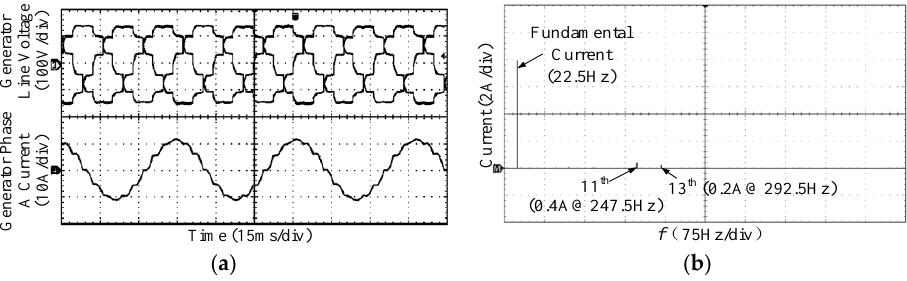
Figure 9. Generator line voltage and phase current. ( a ) Waveforms; ( b ) Fast Fourier Transformation (FFT) analysis on the phase current.